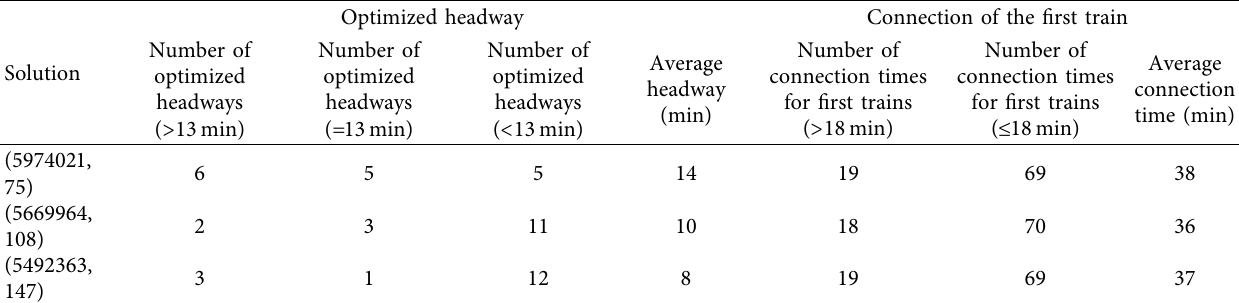
Table 13: Analysis of optimized headway and connection of the first train.